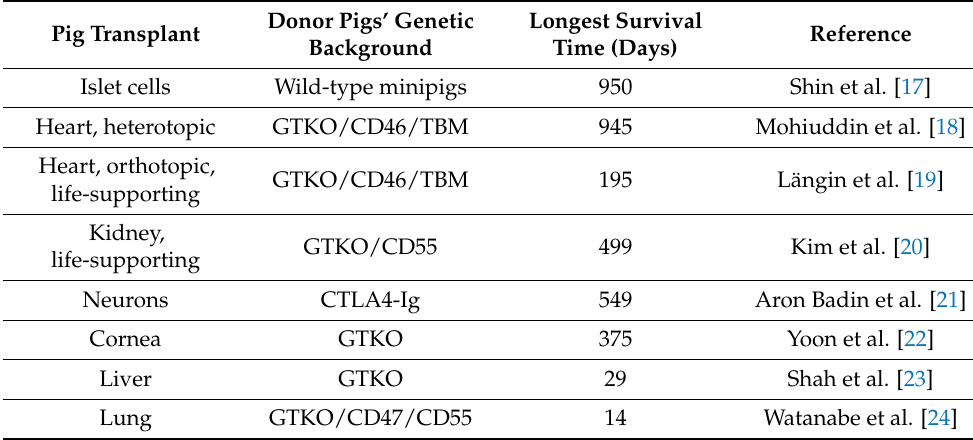
Table 1. Survival time of pig cells or organs in nonhuman